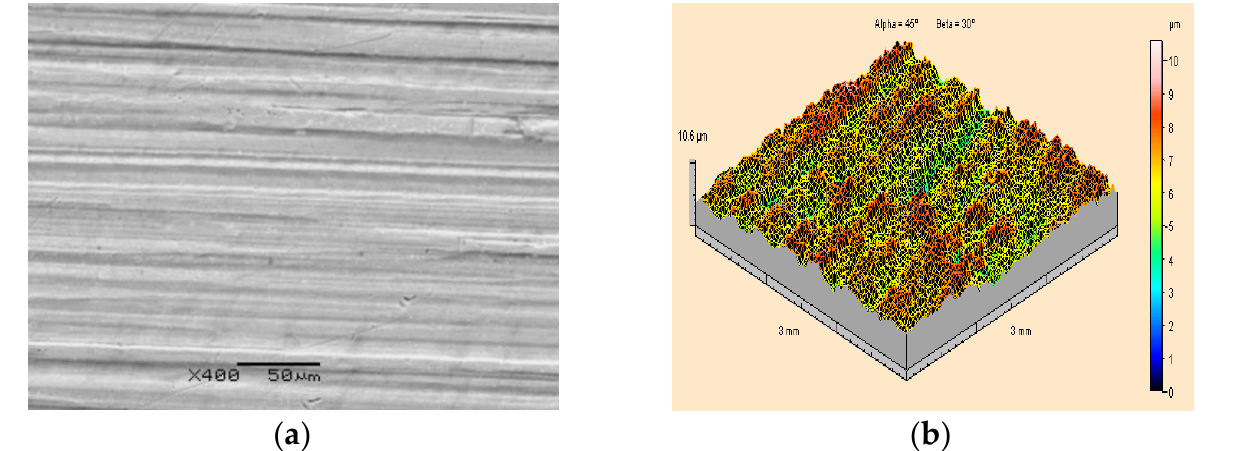
Figure 7. Surface topography of PA2 aluminium alloy specimens after ice-water jet treatment (p w = 35 MPa, m L = 208 kg · h − 1 , l 2 = 250 mm, κ = 90 ◦ ): ( a ) Scanning electron microscope image (400 × magnification); ( b ) Isometric image.